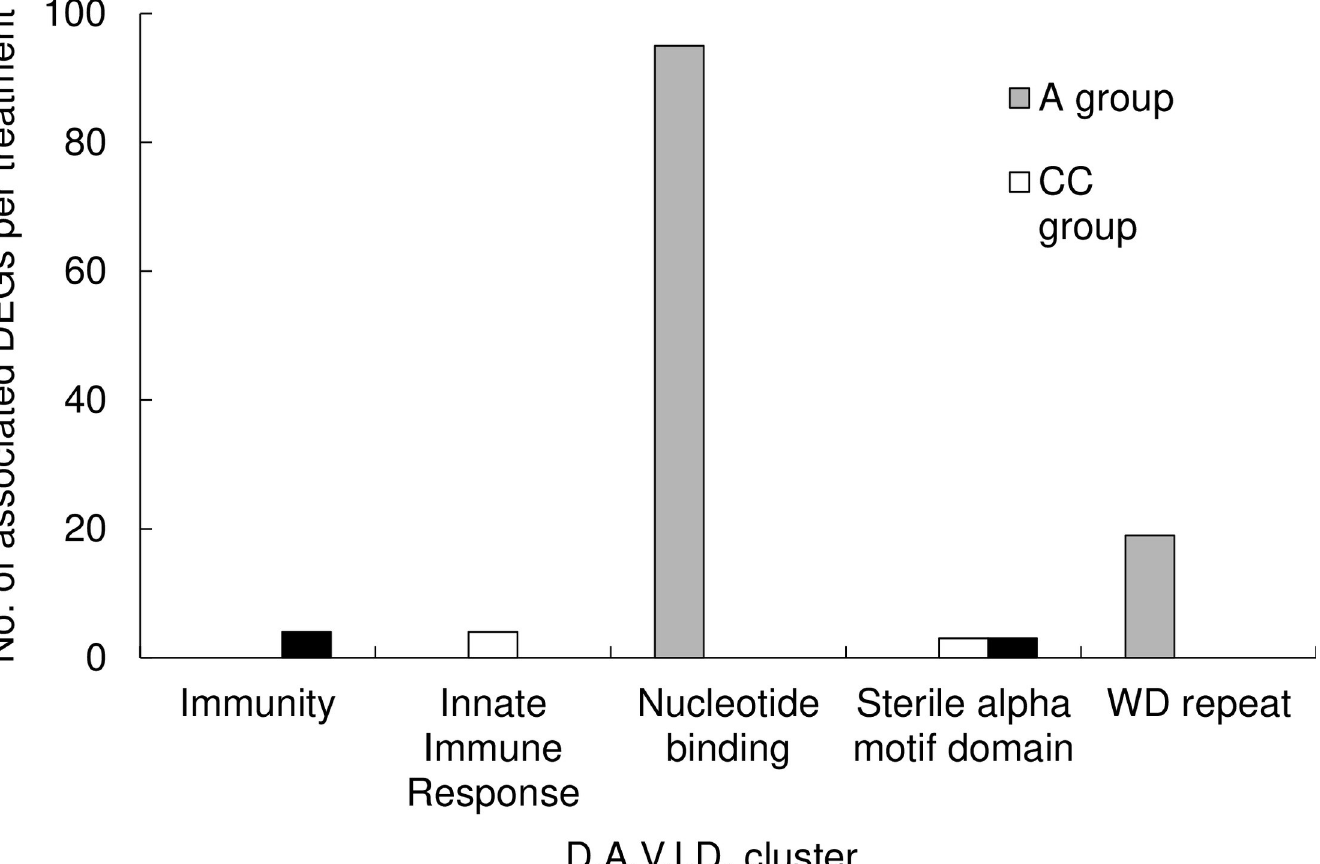
Fig 3. D.A.V.I.D. functional clustering analysis groupings with the number of associated differentially expressed genes (DEGs) for each treatment group compared to the untreated control group. For a list of all the genes per cluster see Tables 4–6. FC group = wax containing a combination of tau -fluvalinate and coumaphos; CC group = wax containing a combination of chlorpyrifos and chlorothalonil; and A group = wax containing